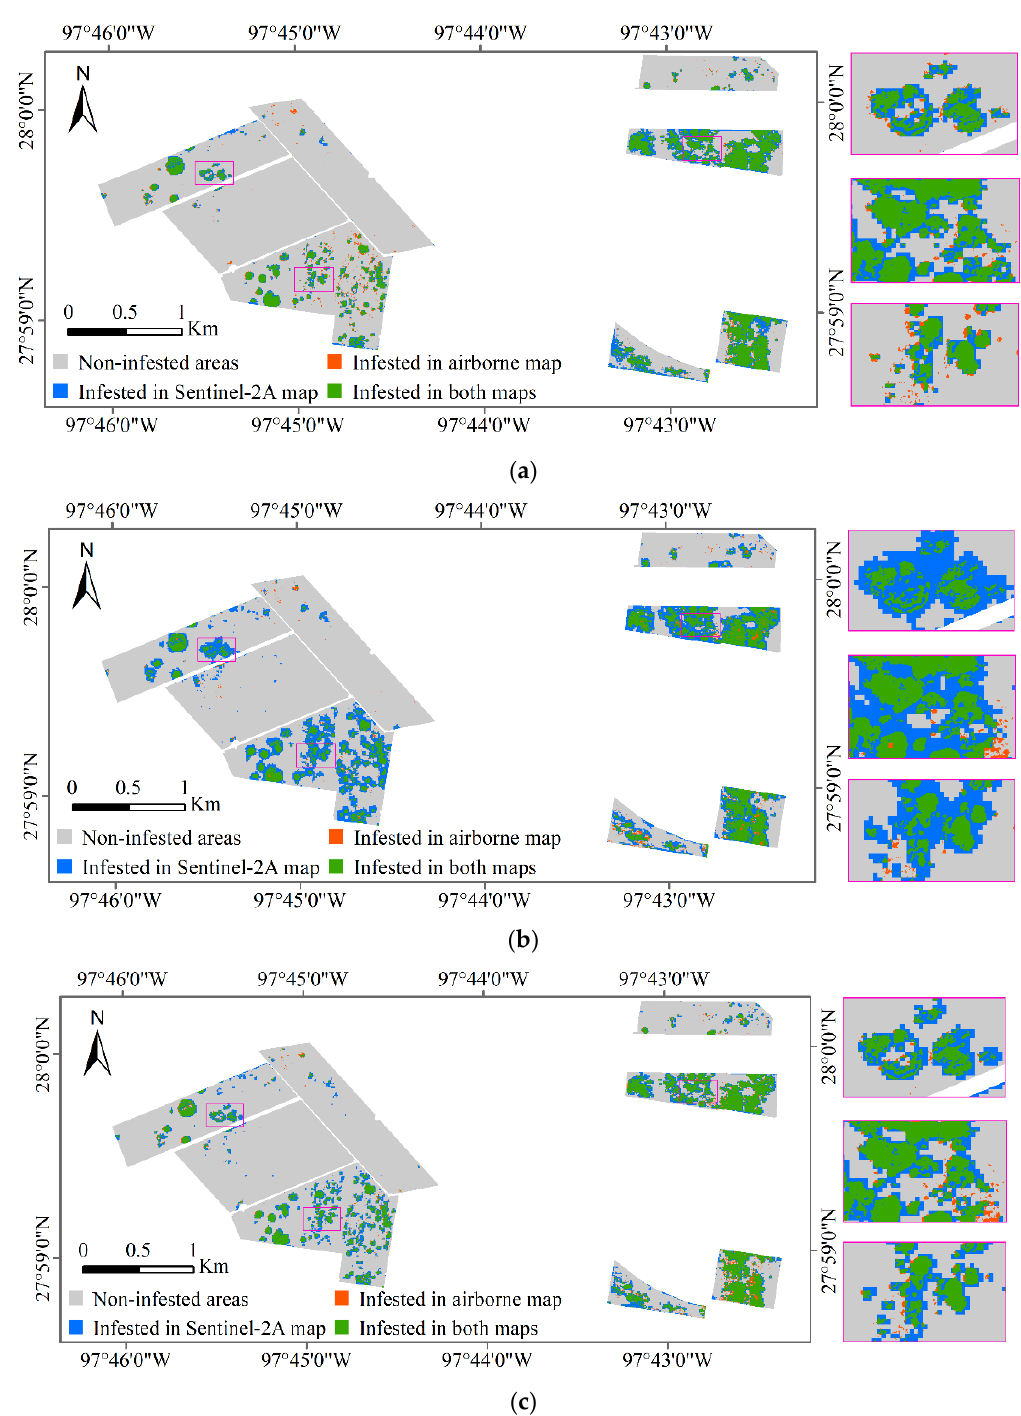
Figure 6. Overlaid cotton root rot classification maps from airborne and Sentinel-2A images for Fields 1–8 and the zoomed in rectangle scenes for the areas marked on the maps are shown at the right. ( a ) Sentinel-2A classification map based on the spectral model; ( b ) Sentinel-2A classification map based on the texture model; ( c ) Sentinel-2A classification map based on the spectral-texture